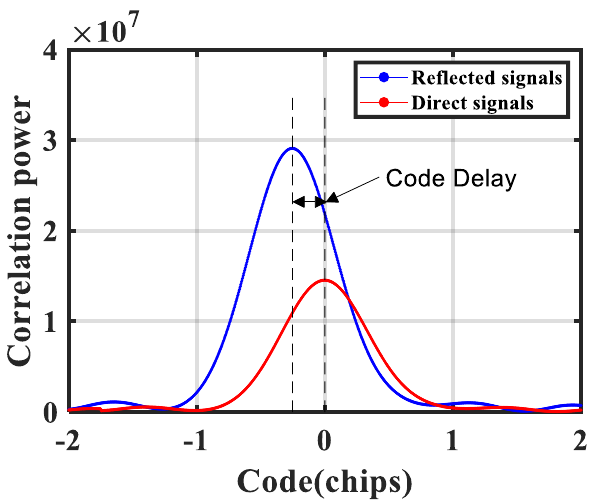
Figure 1. The correlation power waveform of the reflected (blue) and direct signals (red) in coastal conditions.